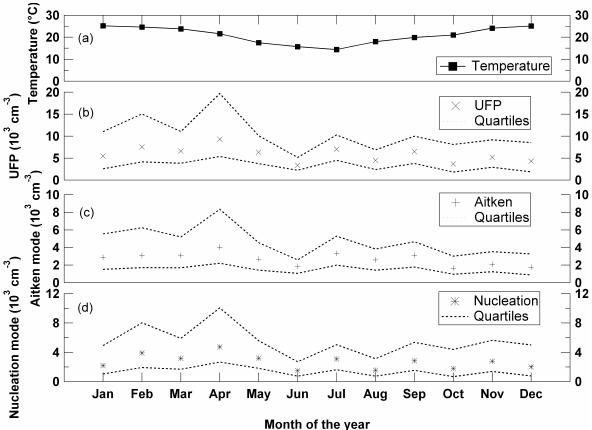
Fig. 2. Monthly variations of (a) mean temperature, and particle number concentration of ultrafine (UFP) (b) , Aitken mode (c) and nucleation modes particles (d) . The median number concentrations and the 1st and 3rd quartiles are presented.